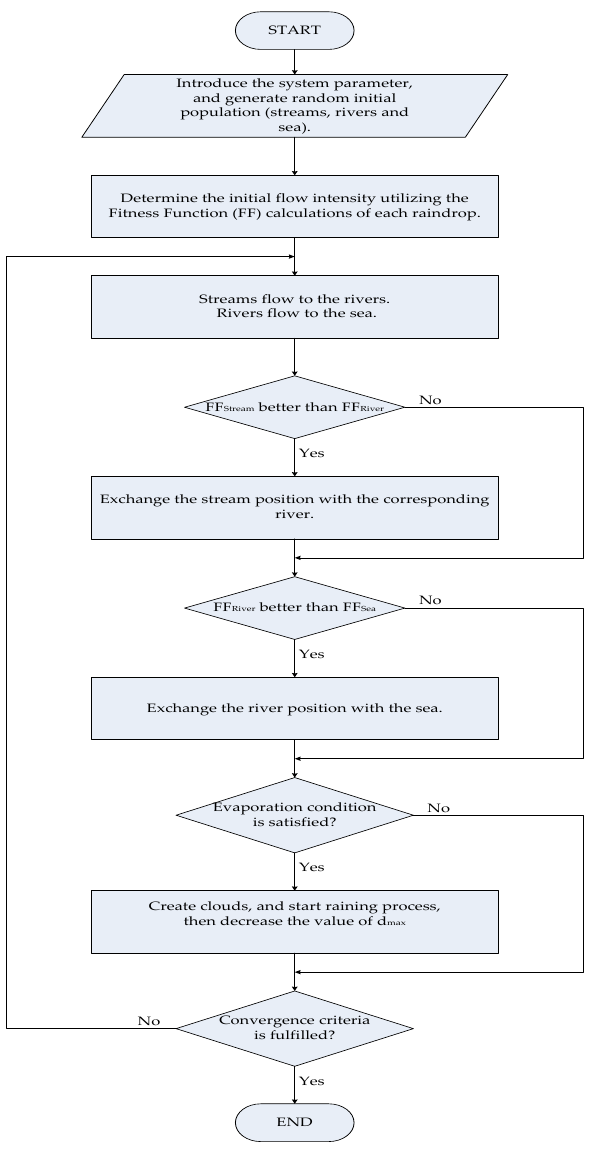
Figure 5. A flowchart for water cycle optimization algorithm.